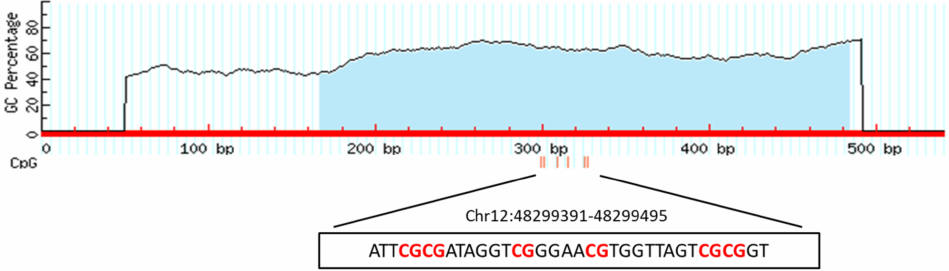
Figure 4. Methylation analysis of promoter CpG island located in VDR locus. CpG island (blue region) identified by MethPrimer program and location of the CpG sites in VDR gene.